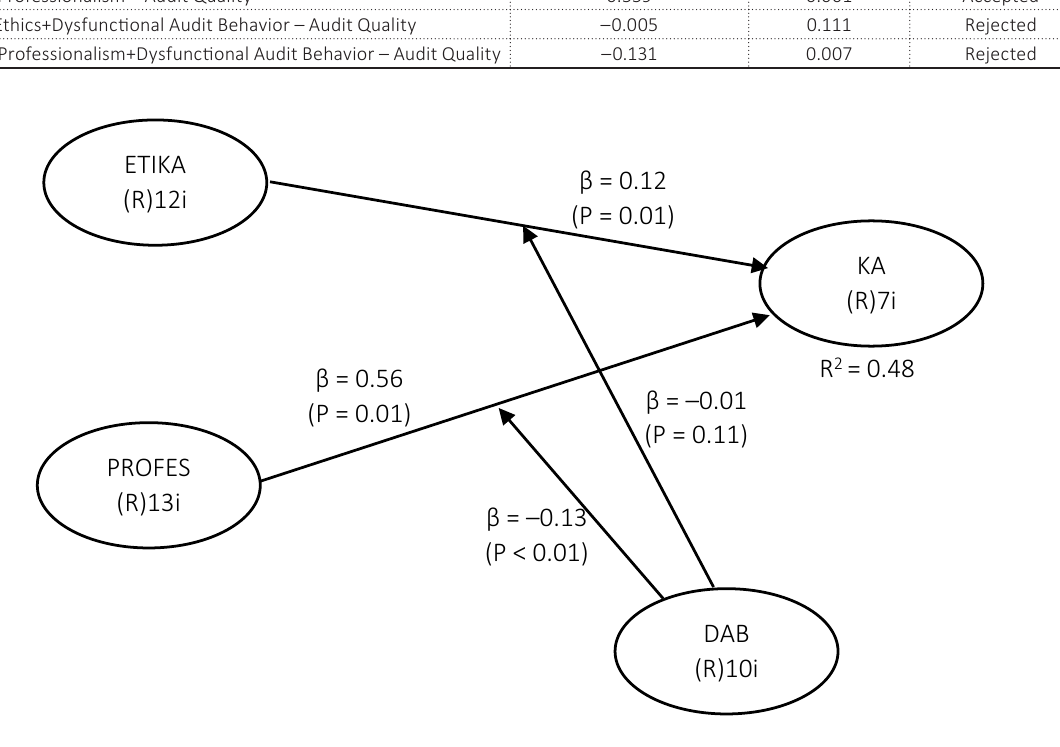
Figure 1. Research model